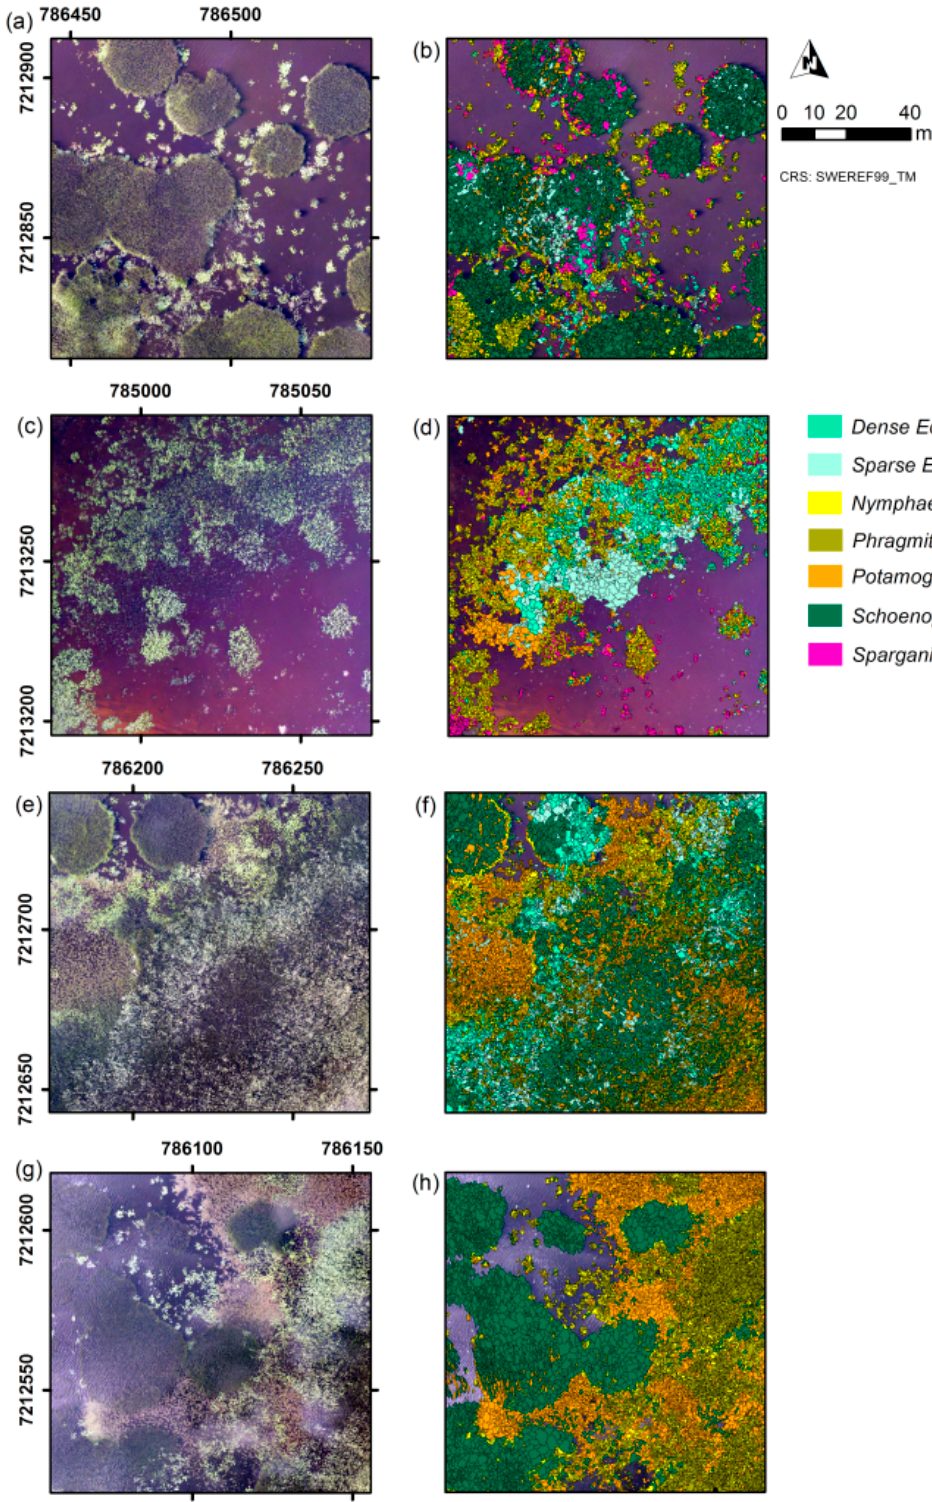
Figure 2. Orthoimage of test sites II ( a ); III ( c ); IV ( e ); and V ( g ) and corresponding dominant-taxon classification using Random Forest at test sites II ( b ); III ( d ); IV ( f ); and V ( h ).